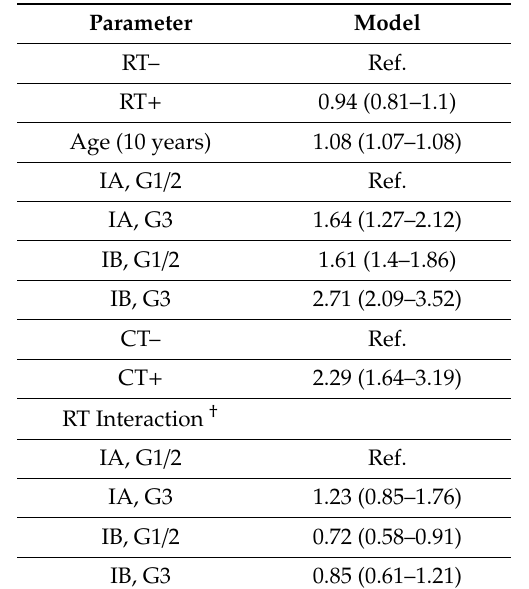
Table 3. Multivariate analysis of relative survival model in relation to FIGO / grade risk constellation considering all early-stage T1, N0 / x, M0 / x